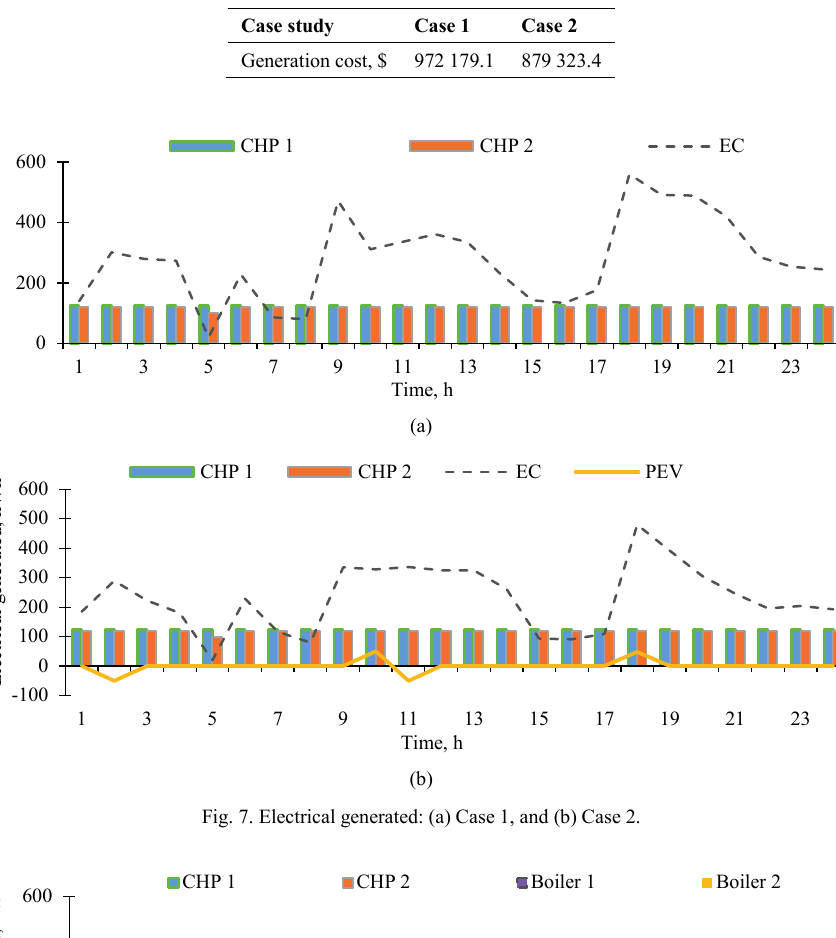
Fig. 7. Electrical generated: (a) Case 1, and (b) Case